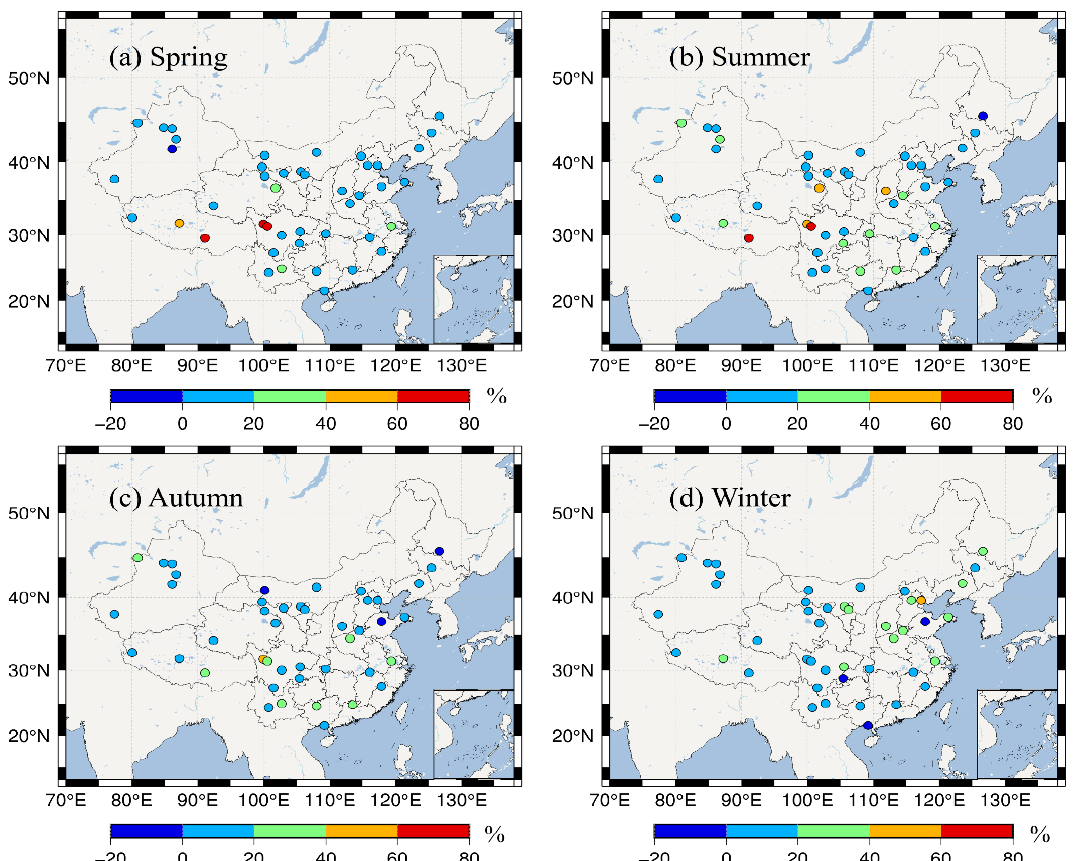
Figure 12. Distribution of the improvement rates of all verification stations in different seasons at spatial scales.